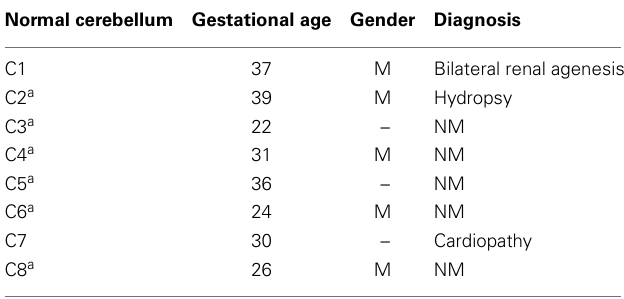
Table 2 | Summary of the normal cerebellum